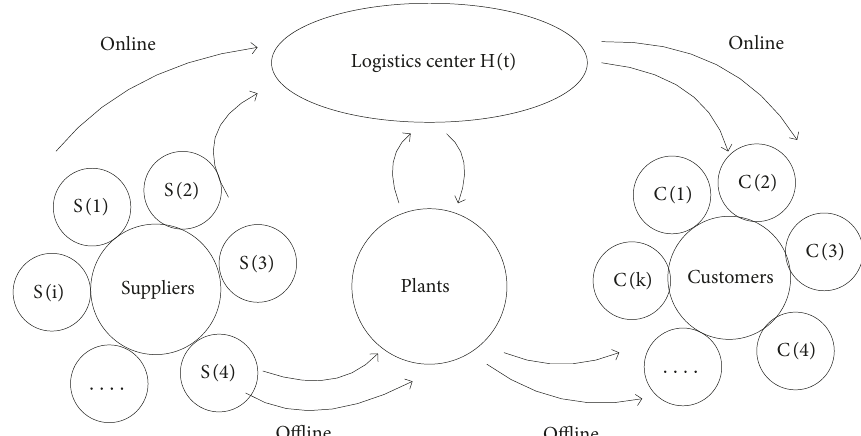
Figure 1: Conceptual model of single-plant location.